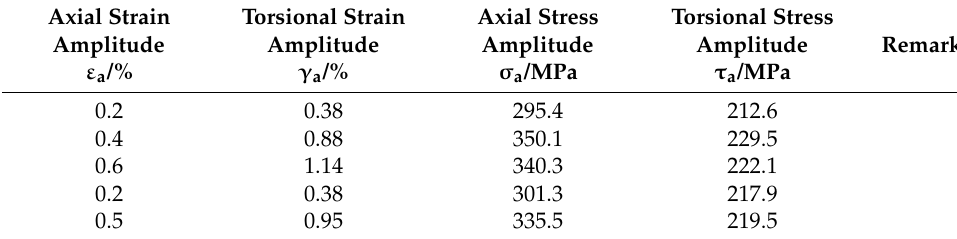
Table A8. Test results for proportional tests ( γ a / ε a =